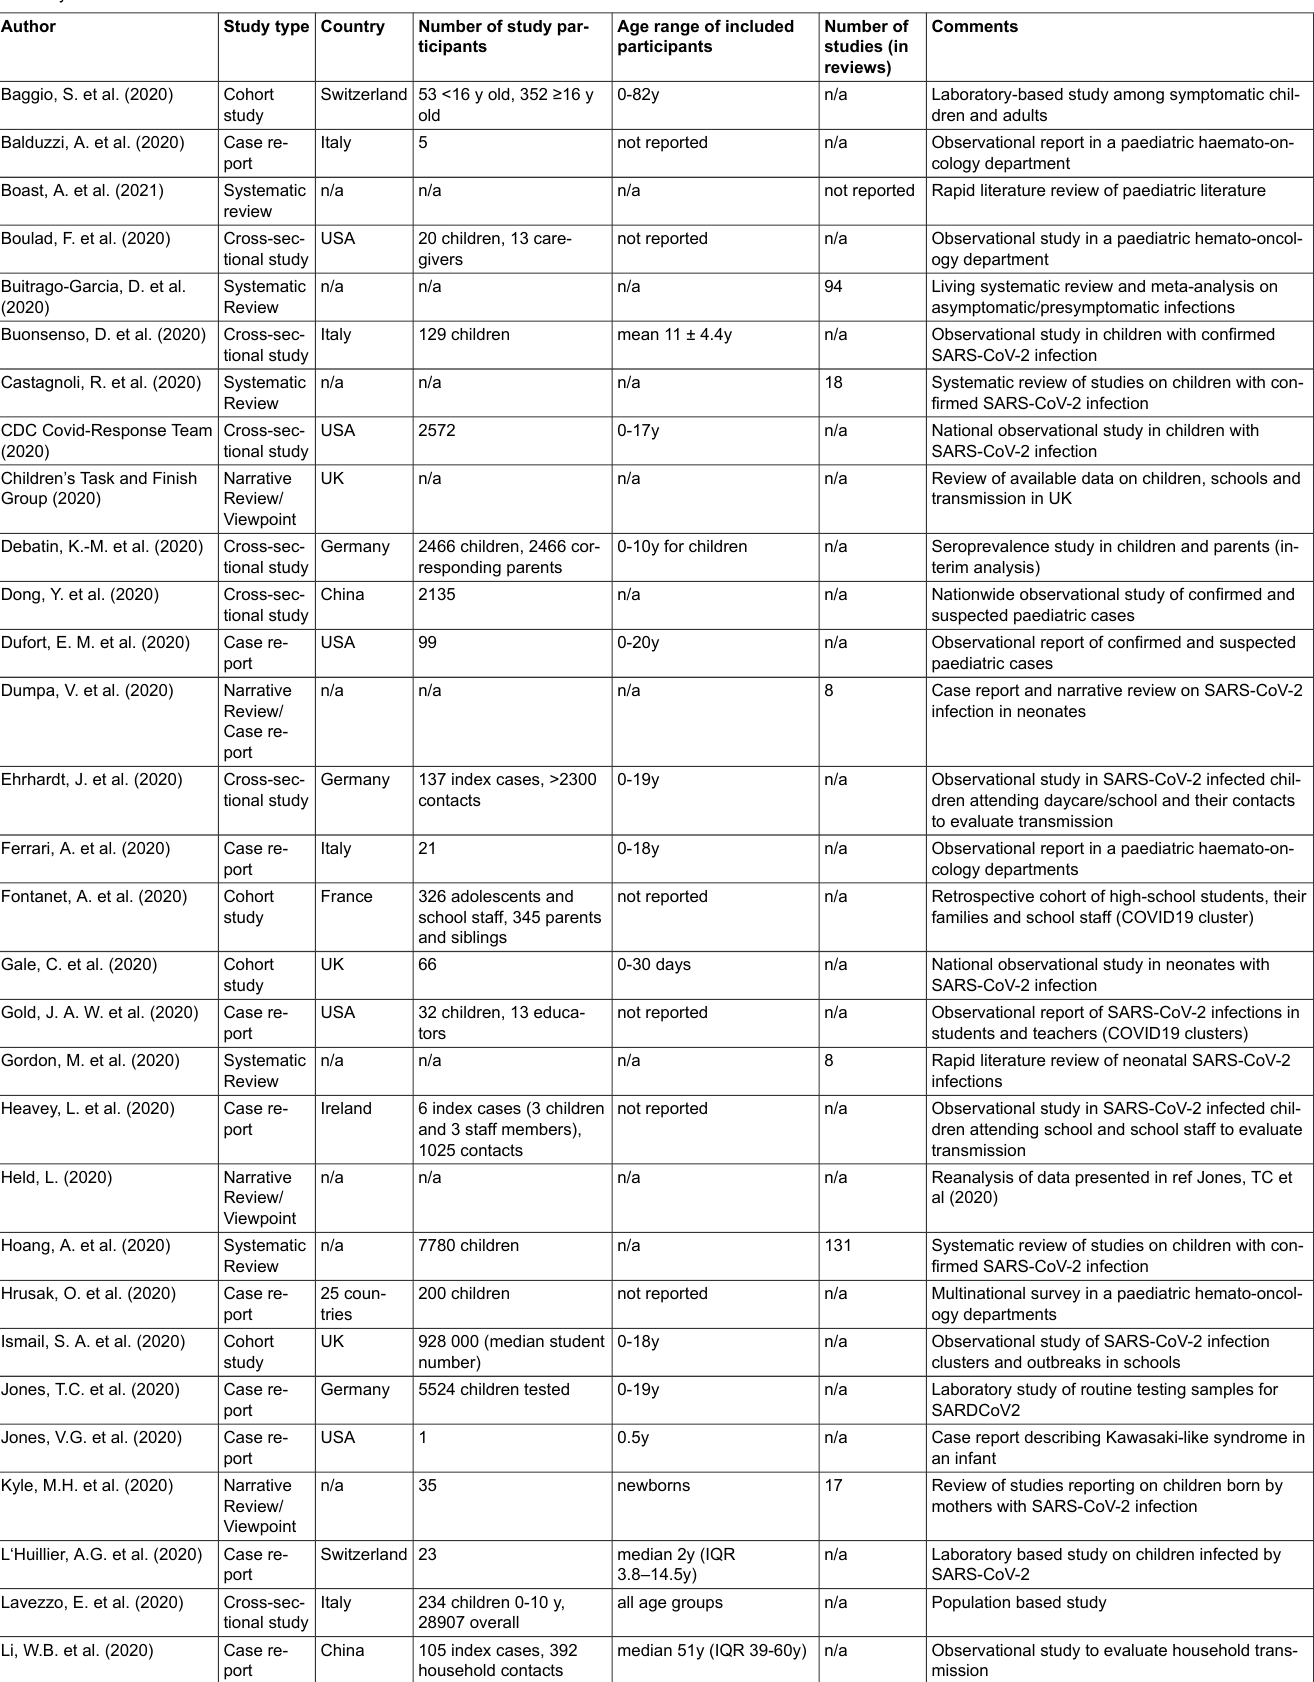
Table S1: Summary of characteristics of studies included in the